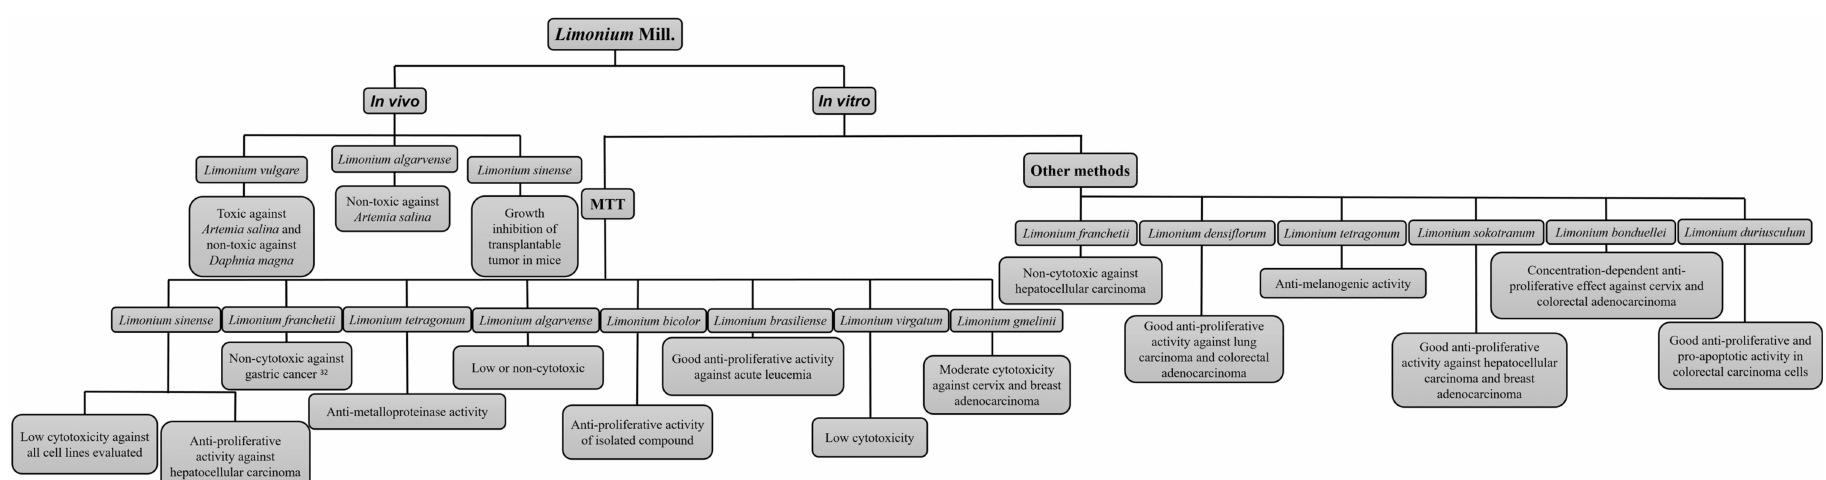
Figure 2. Main results of in vivo and in vitro assays of eligible studies included in the systematic review. Fonte: Adapted from Medini et al. [18], Al-madhagi et al. [22], Lellau et al. [25], Tang et al. [26,28], Kong et al. [27], Bae et al. [29,31], Chen et al. [32], Cordeiro [33], Lee et al. [34], Sahli et al. [35], Amrani et al. [36], Hamadou et al. [37], Rodrigues et al. [30,38], Tuohongerbieke et al.